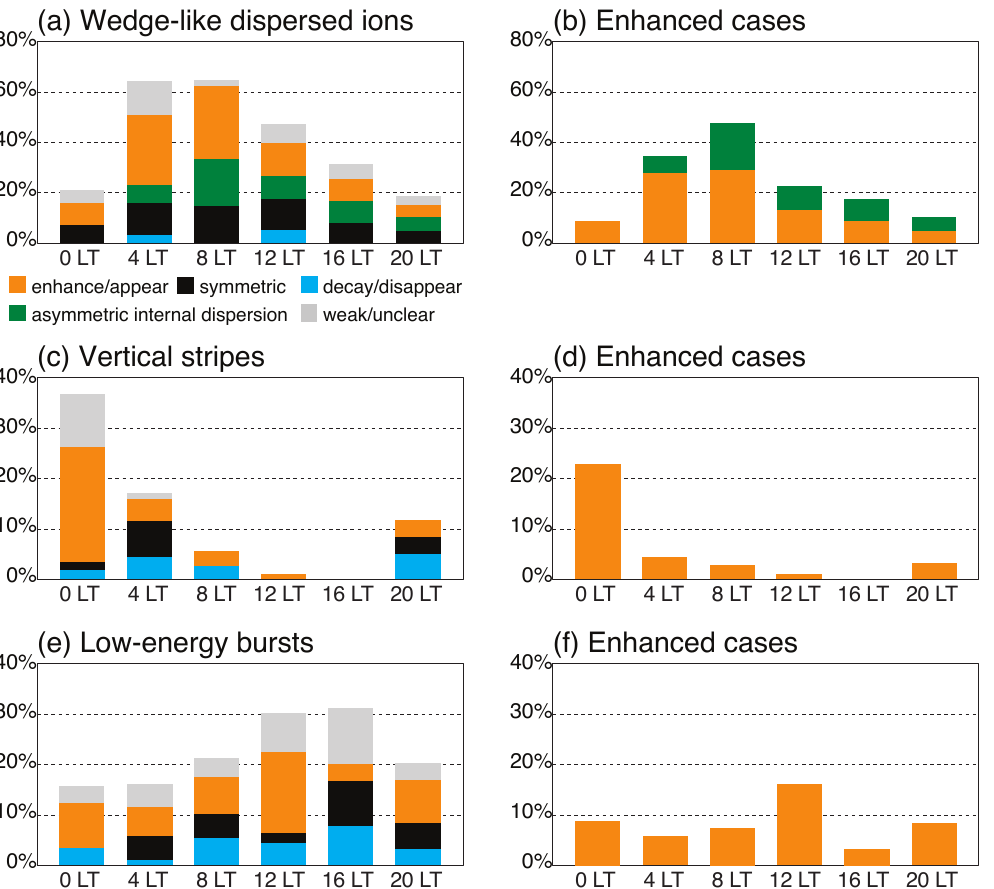
Fig. 5. Observation frequency (%) of (a) – (b) wedge-like dispersed ions, (c) – (d) vertical stripes, and (e) – (f) short bursts of low-energy ions at different local time (LT) sectors, during Cluster SC-4 perigee traversals during the 2001–2006 period (494 traversals). Traversals with inbound–outbound difference (increase or decrease) are defined by more than about a factor of 3 changes in the differential energy flux. The total number of traversals in each 4h bin is 57, 87, 108, 93, 90, and 59, for 22–02LT, 02–06LT, 06–10LT, 10–14LT, 14–18LT, and 18–22LT,